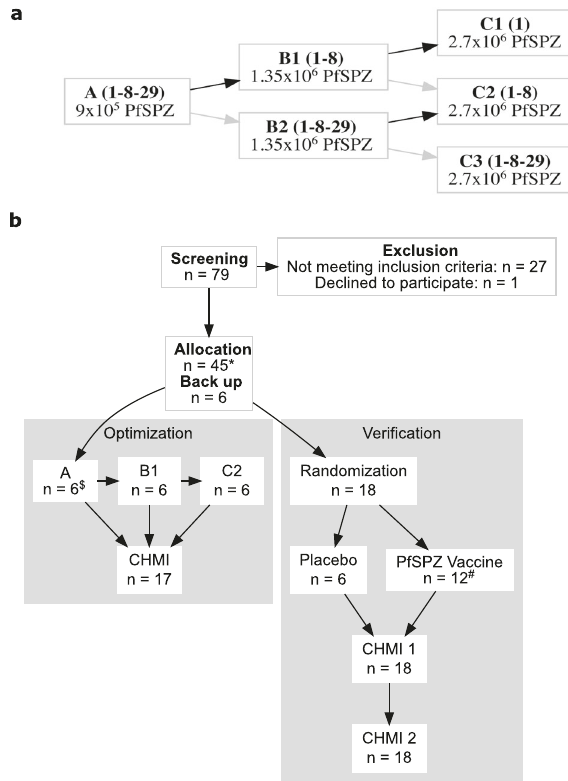
Fig. 1 Study fl ow Chart. a Optimization of PfSPZ Vaccine regimen and ( b ) Veri fi cation of PfSPZ Vaccine regimen. *9 of the 45 subjects were allocated to a 7G8 safety analysis that will be published elsewhere. $ One volunteer received only the fi rst vaccination. # One volunteer received the 2nd vaccination on day 15 instead of day